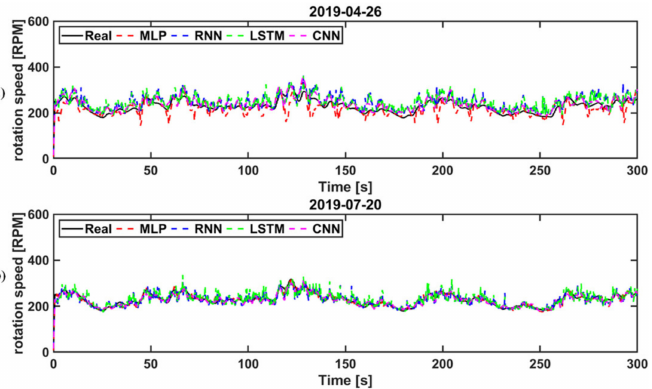
Figure 16. Comparison of the prediction performances of each algorithm for the conditions of Cases 3 and 4. Prediction result of test dataset 16 August 2019 using ( a ) the 26 April 2019 training dataset and ( b ) the 20 July 2019 training dataset.